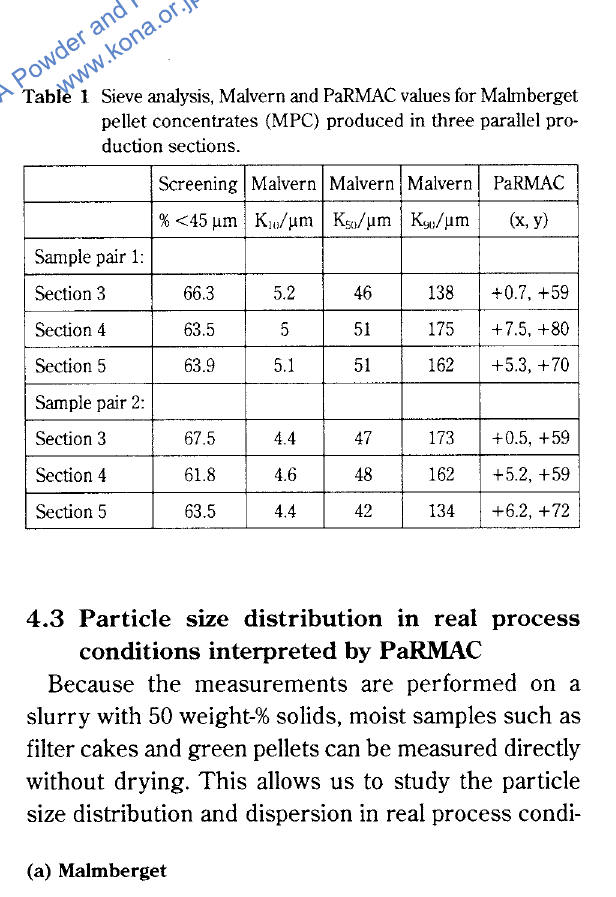
Table 1 Sieve analysis, Malvern and PaRMAC values for Mahnberget pellet concentrates (MPC) produced in three parallel pro duction sections.